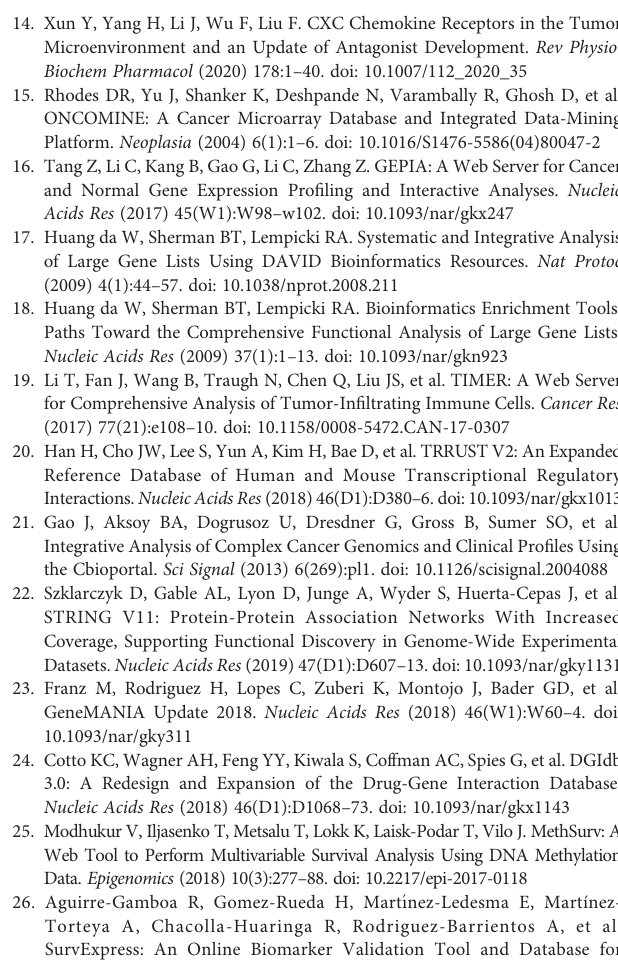
Supplementary Figure 1 | The protein expression of CXCL4/5/7/8/11/12/13/ 14/16 in normal pancreatic tissues and PAAD tissues (the Human Protein Atlas). Supplementary Figure 2 | The correlation among each CXC chemokine (SurvivalMeth). Supplementary Figure 3 | Correlations between the expression of CXC chemokines and BRCA1 mutated genes (cBioportal).